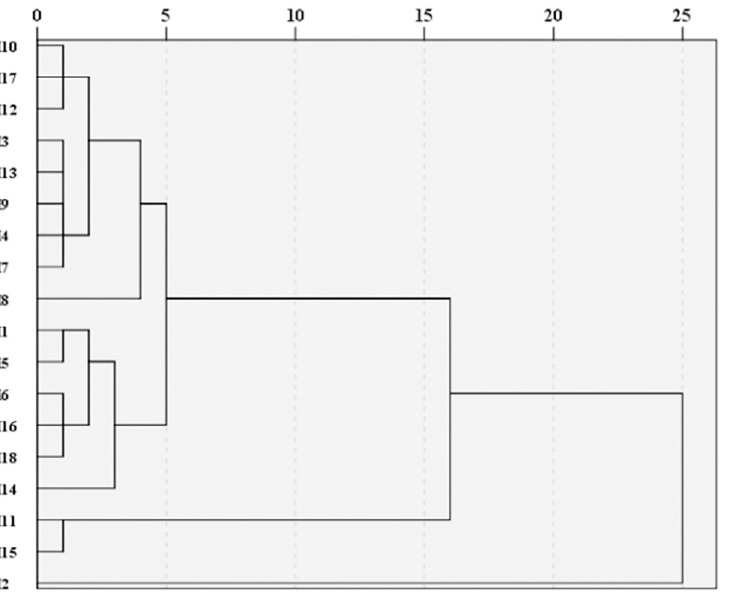
Fig 2. FTIR cluster analysis diagram of M1 ~